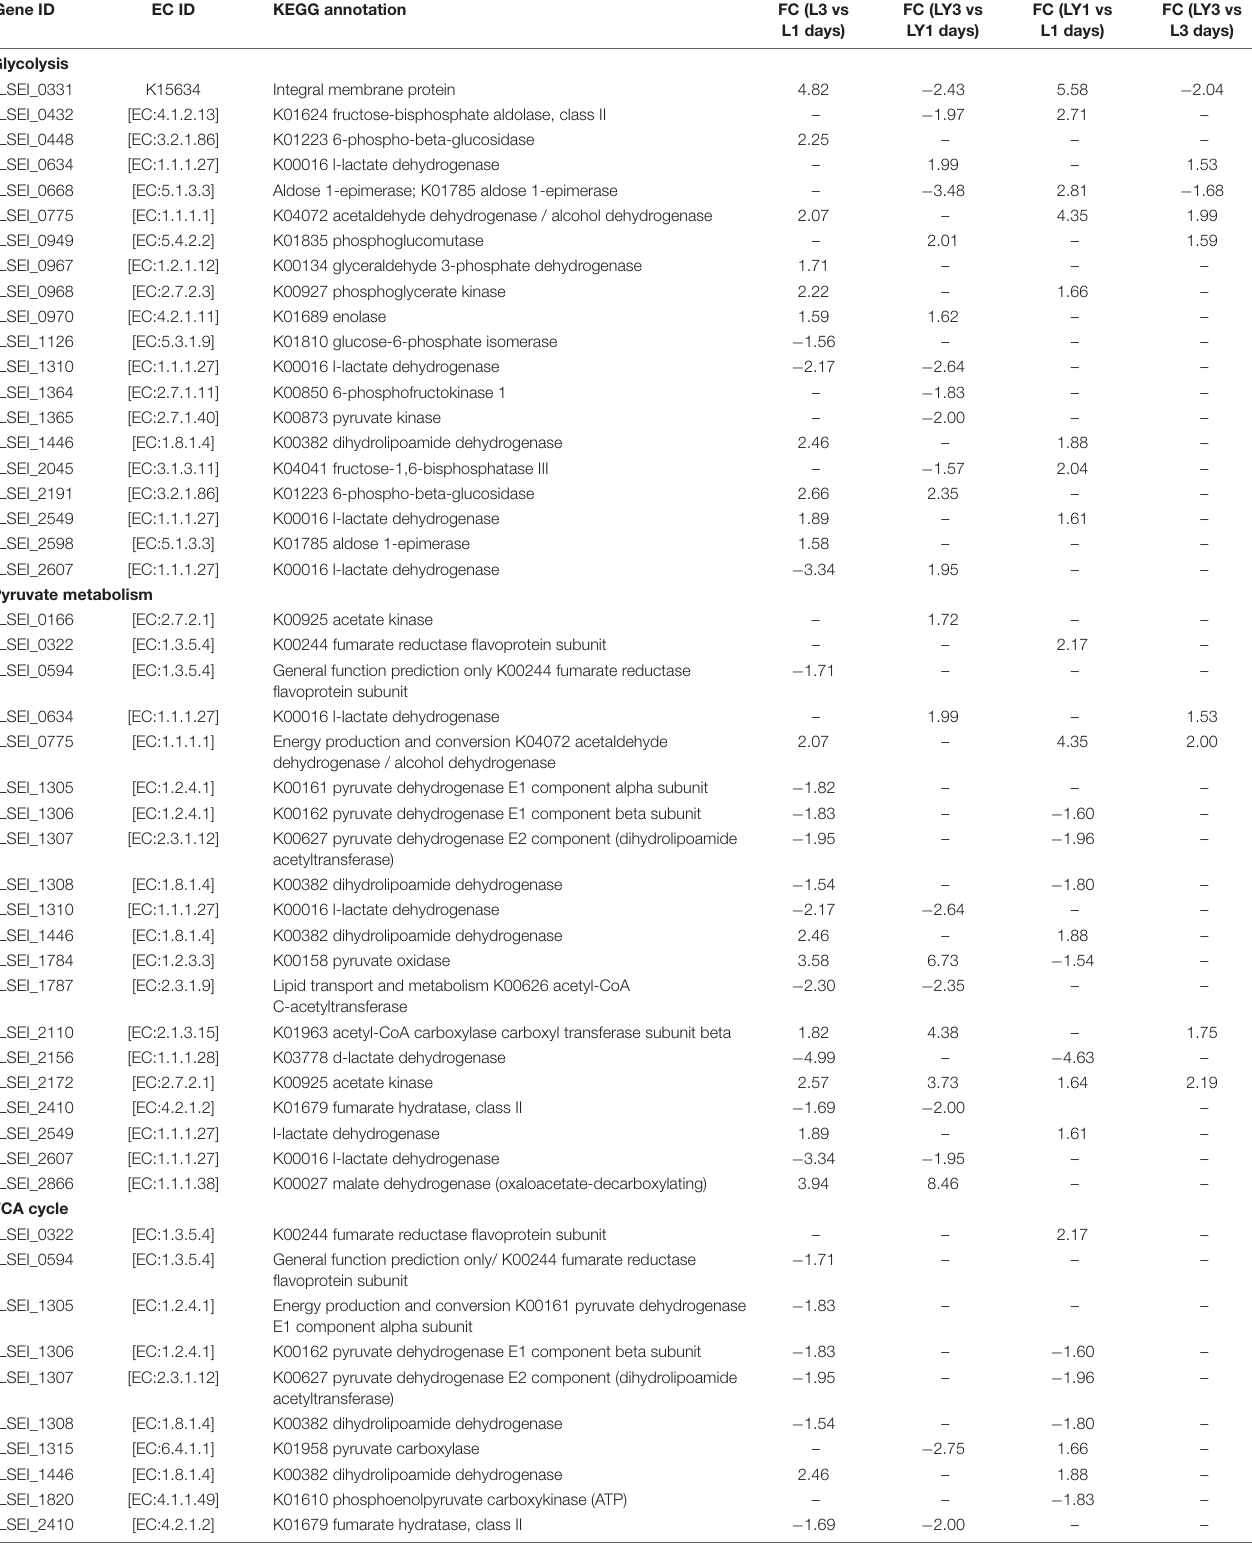
TABLE 1 | The key genes involved in glycolysis, pyruvate metabolism, and TCA cycle in single inoculation with L. paracasei and mix inoculation during rice-acid fermentation process among four pairwise comparisons. Gene ID EC